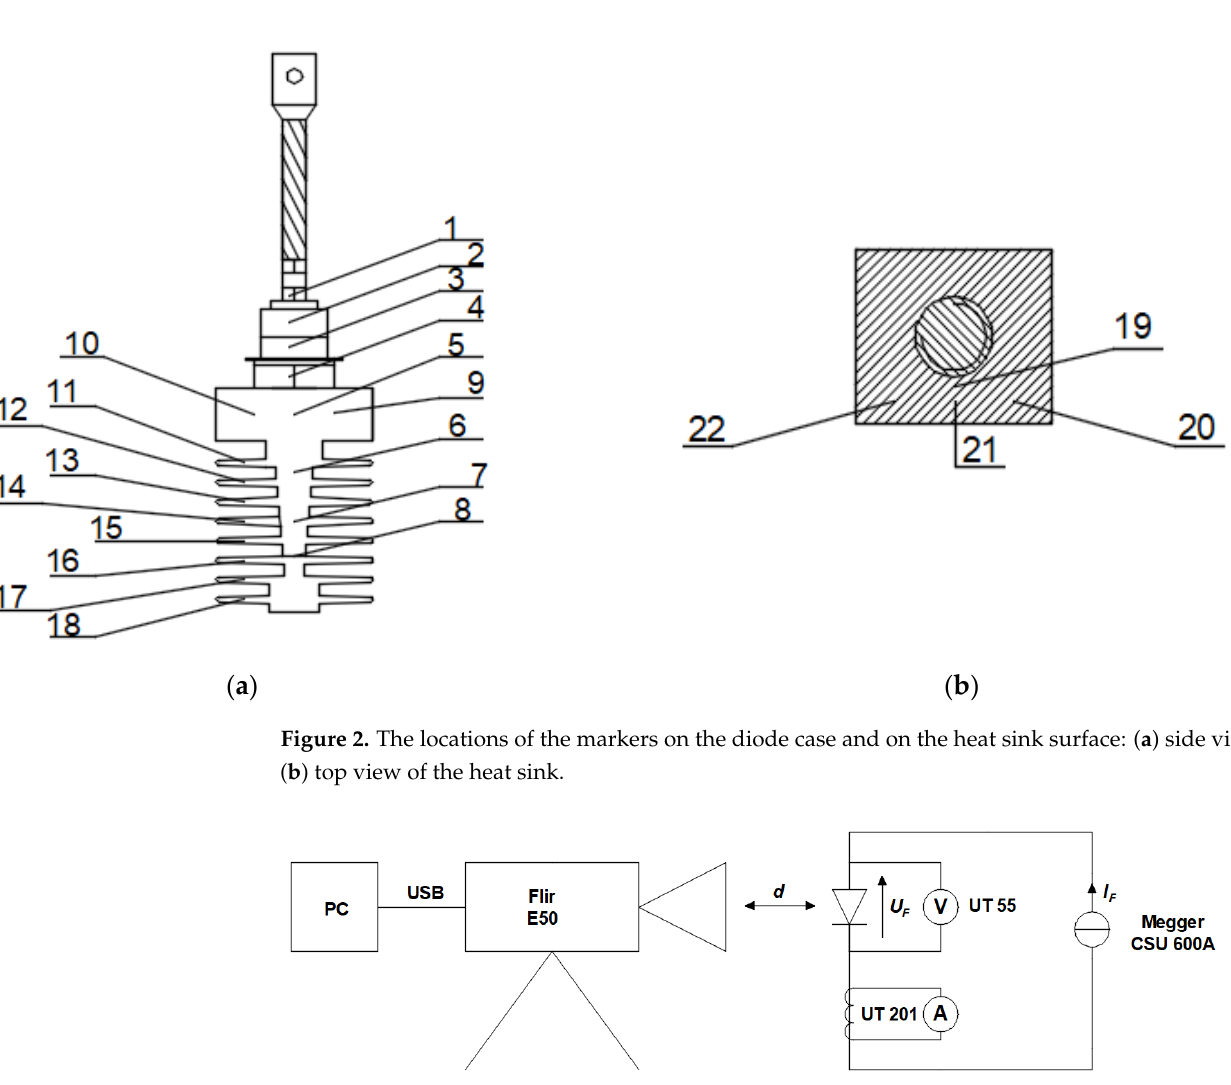
Figure 3. Scheme of the measuring system.